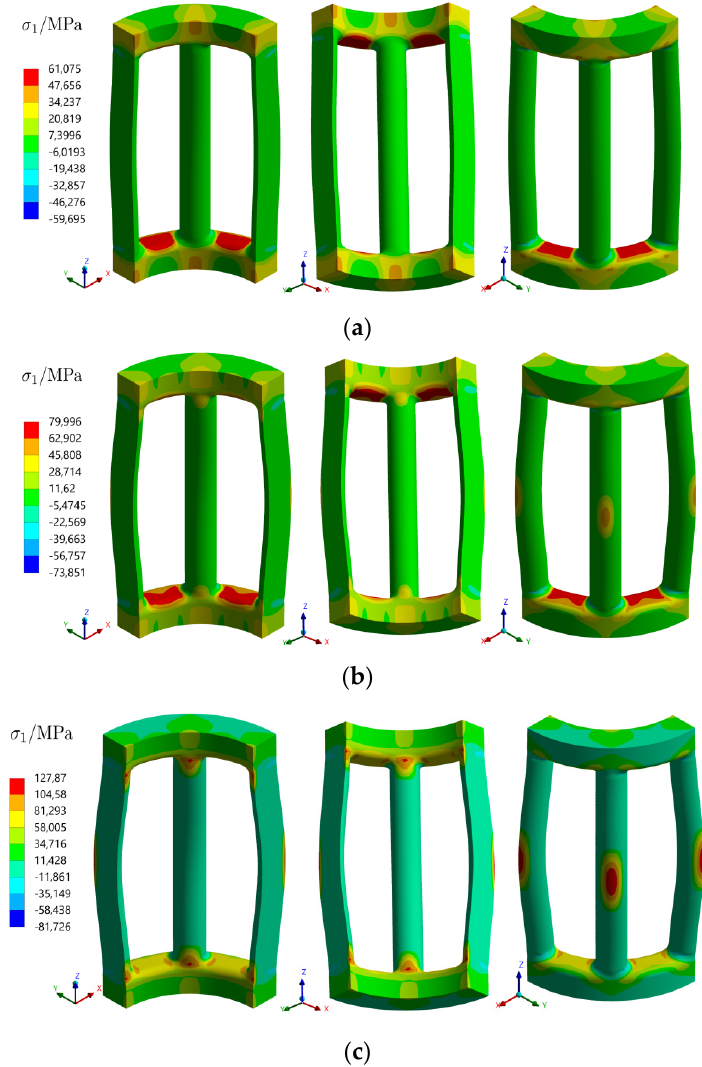
Figure 10. Results of analysis for the maximum principal stress: ( a ) @780 N load; ( b ) @806 N